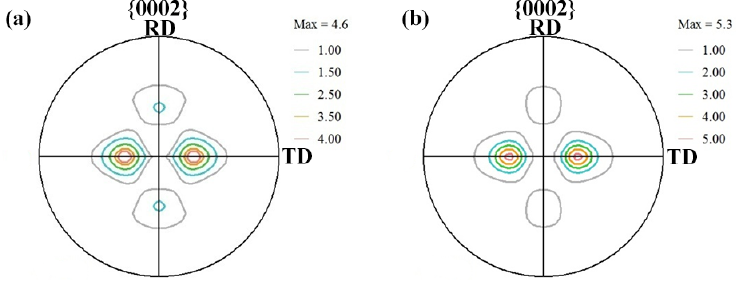
Figure 5. {0001} pole figures through X ‐ ray diffraction of cold rolled samples with 90% reduction following 1000 °C of annealing for ( a ) 1 min, and ( b ) 3 min.